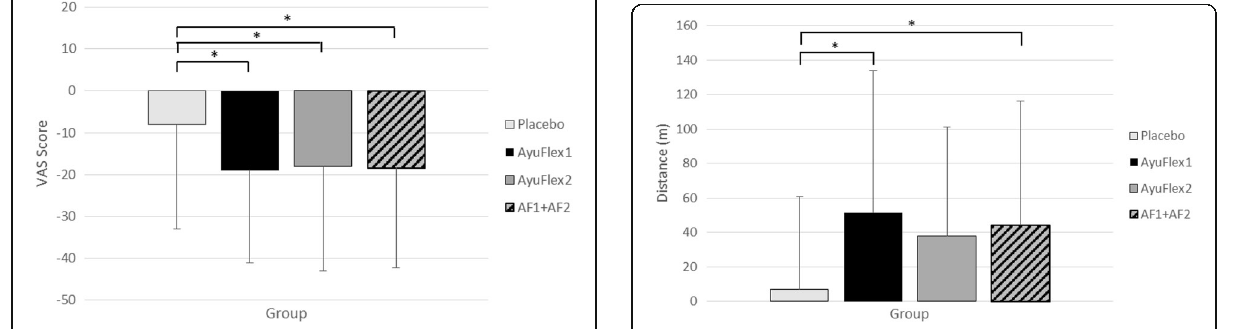
Fig. 10 Mean ± SD changes in the distance covered during the 6- min walk test. Significant differences were noted between the Ayu- Flex 1 group ( p = 0.019) and the combined Active Groups (AF1 + AF2) ( p = 0.022) vs.